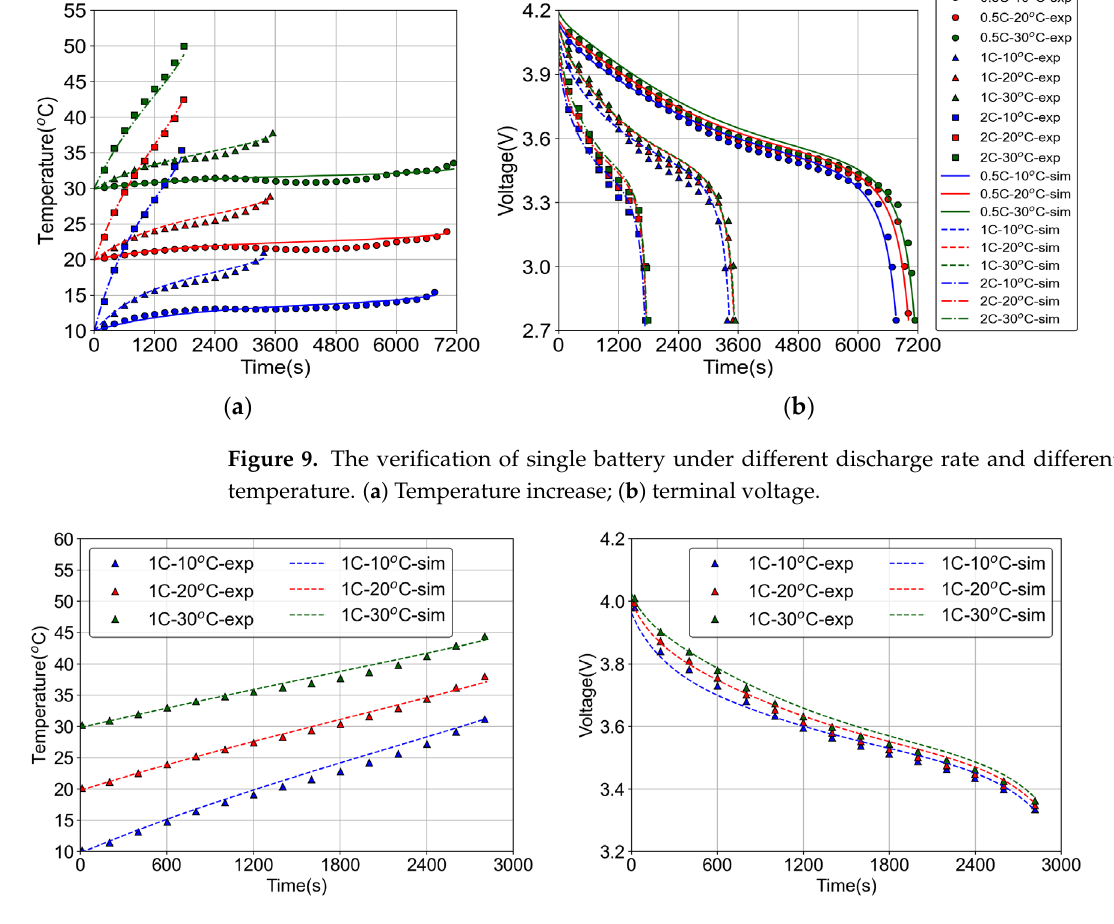
Figure 9. The verification of single battery under different discharge rate and different ambient temperature. ( a ) Temperature increase; ( b ) terminal voltage.